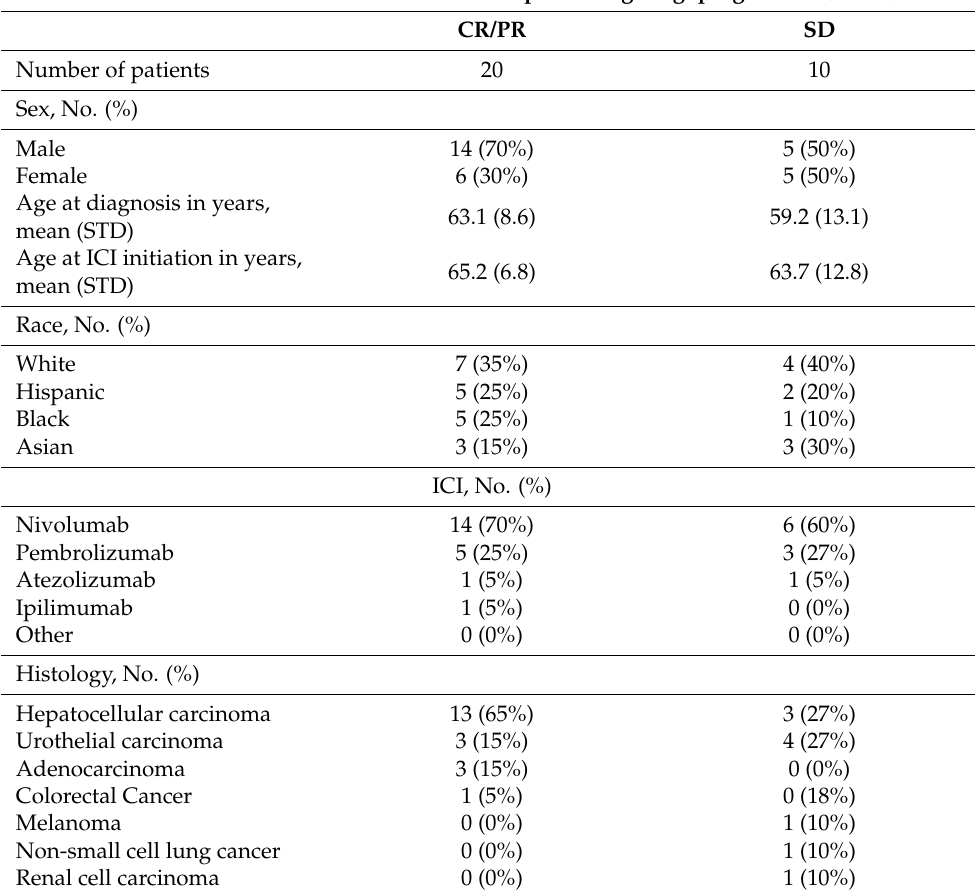
Table 1. Baseline characteristics of patients who experienced oligoprogression by best response to immune checkpoint